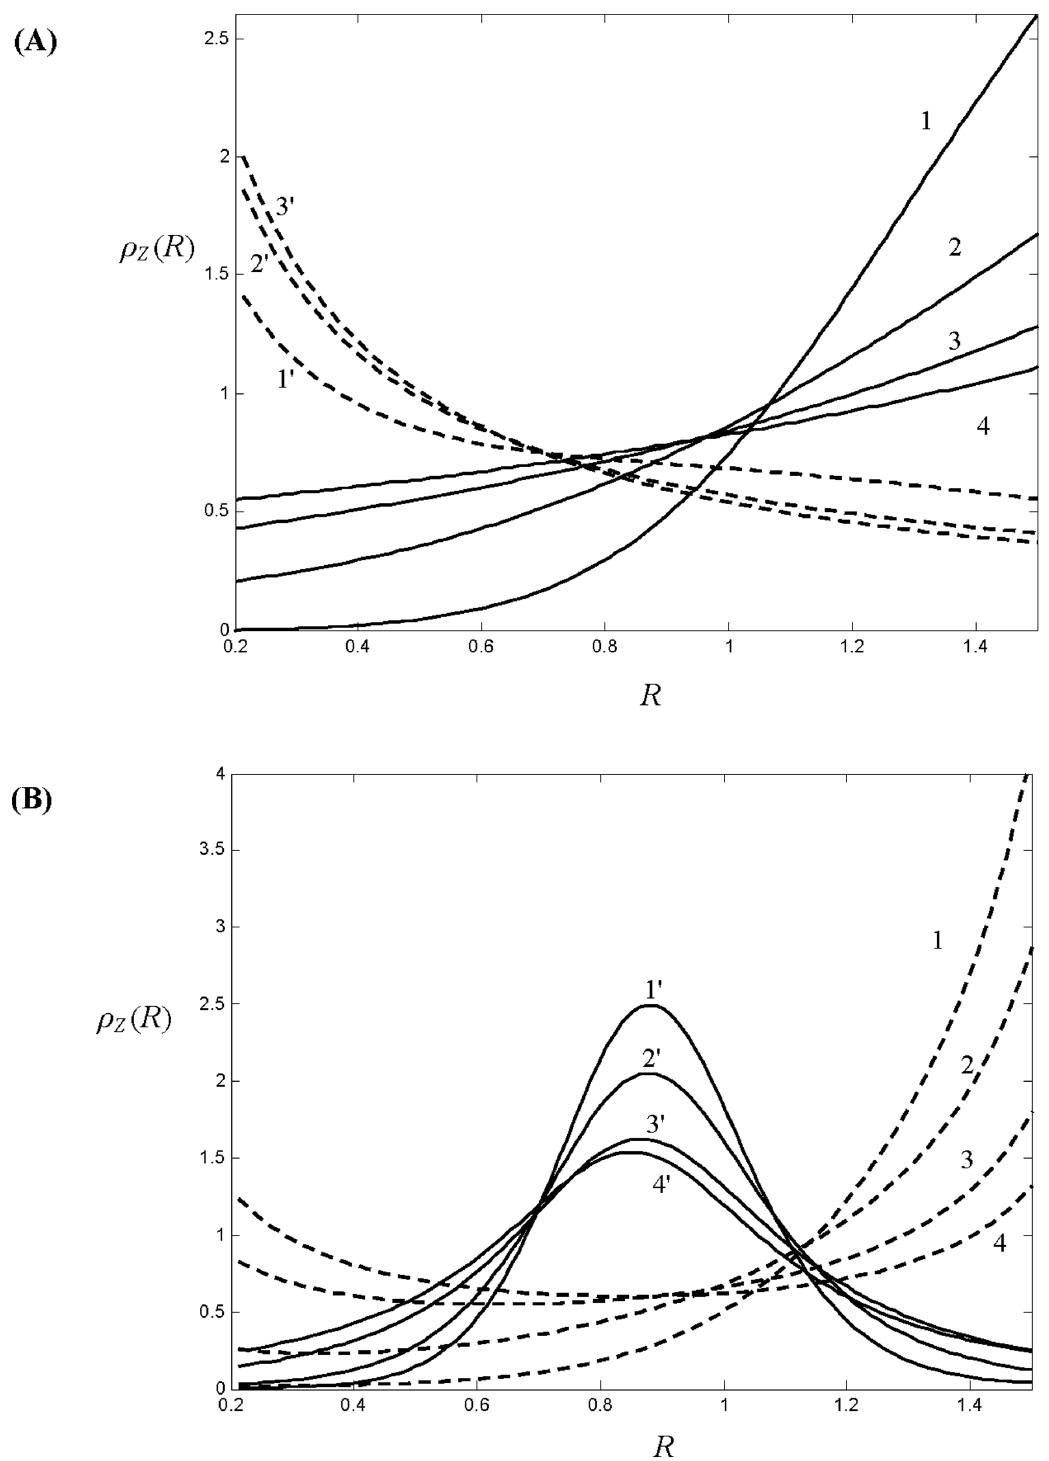
Figure 3. Density r z ( R ) of distribution of individuals in the prey population structured according to the growth rate R at equilibrium. (A) r z ( R ) are plotted for the linear trade-off relation a ( R ) given by (6). The solid line curves correspond to the case of a negative trade- off between a and R ( a 0 =1; Da = 2 0.4); curves 1–4 are constructed for D =0.35, 0.7, 1.5, 4, respectively. The dashed-line curves correspond to a positive correlation between a and R ( a 0 =0.2; Da = 0.72); curves 1 9 –3 9 are constructed for D =5, 1, 0.3. (B) r z ( R ) are plotted for the non-monotonic trade-off relation given by (7). The solid line curves 1 9 –4 9 correspond to Da , 0 ( a 0 =1; Da = 2 2), constructed for D =0.2, 0.4, 1, 5, respectively; the dashed-line curves 1–4 correspond to Da . 0 ( a 0 =1; Da = 2) and plotted for D =0.3, 0.45,1.2, 5. The other model parameters are m= 0.1; b =0.015; h =0.5.